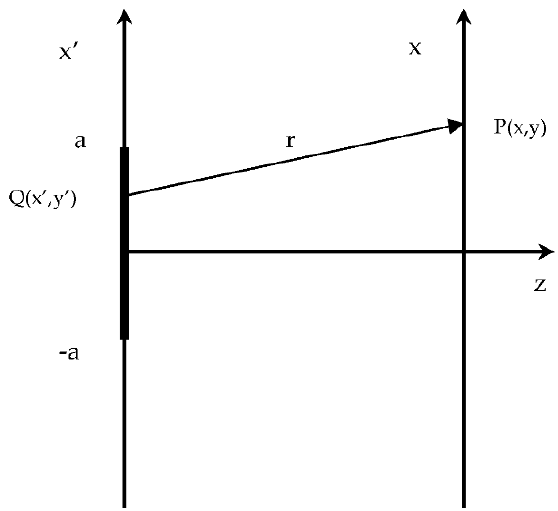
Figure 2. Scheme for propagation of light from the input plane to the output plane.